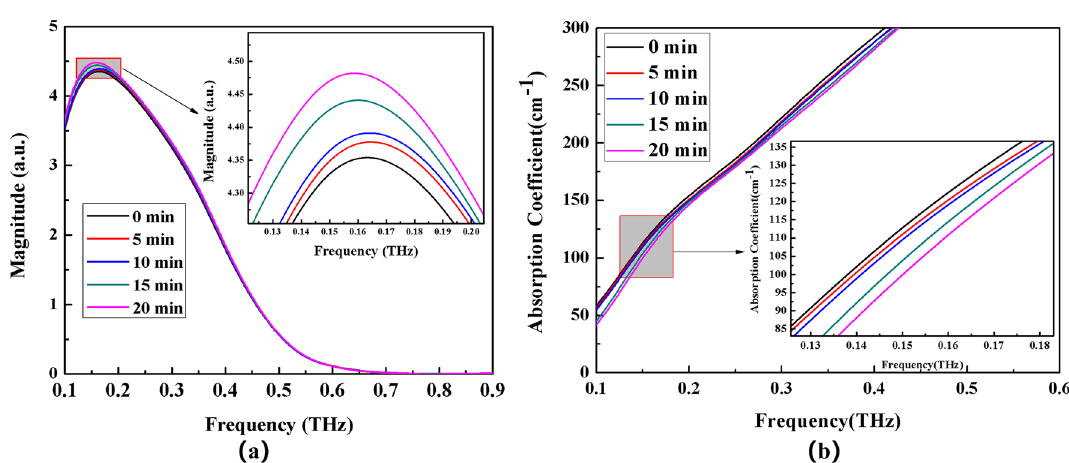
Figure 7. Frequency domain spectrum ( a ) and absorption coefficient spectrum ( b ) of (NH 4 ) 2 SO 4 solution with different time electric field applied externally.